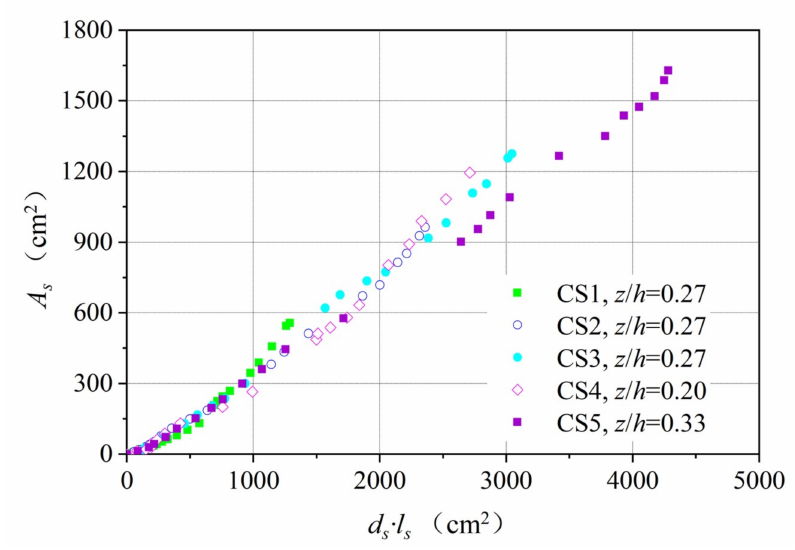
Figure 6. Relationship between averaged longitudinal scour area and scour hole